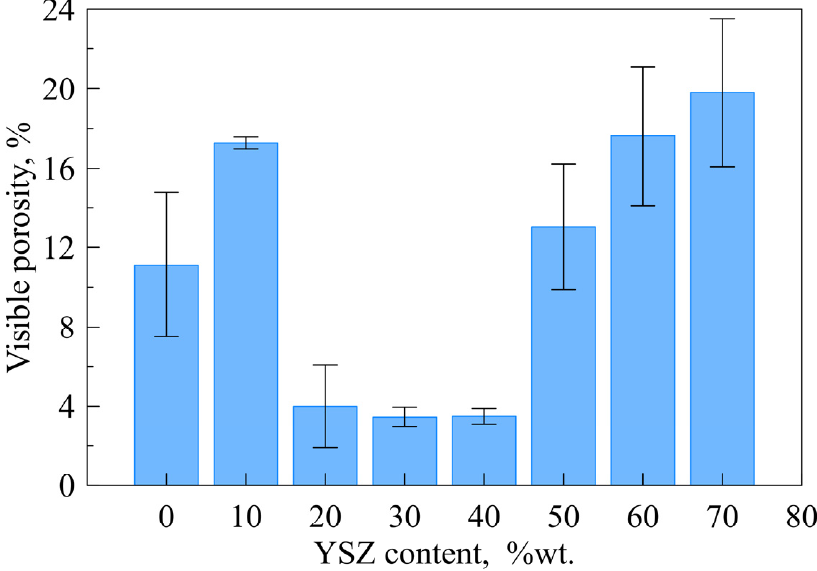
Figure 5. Porosity of the glass and composite layers after the sealing procedure vs. YSZ content.